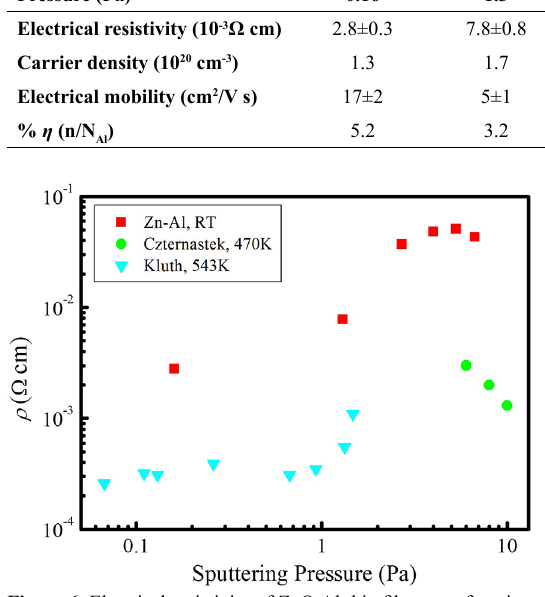
Figure 6. Electrical resistivity of ZnO:Al thin films as a function of the sputtering pressure. Literature values from Czternatek 18 and Kluth et al. 19 are also